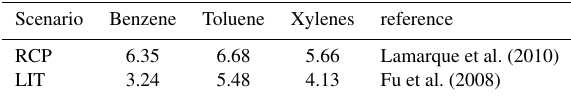
Table 2. Total annual anthropogenic emissions for the different emission scenarios in TgCyear − 1